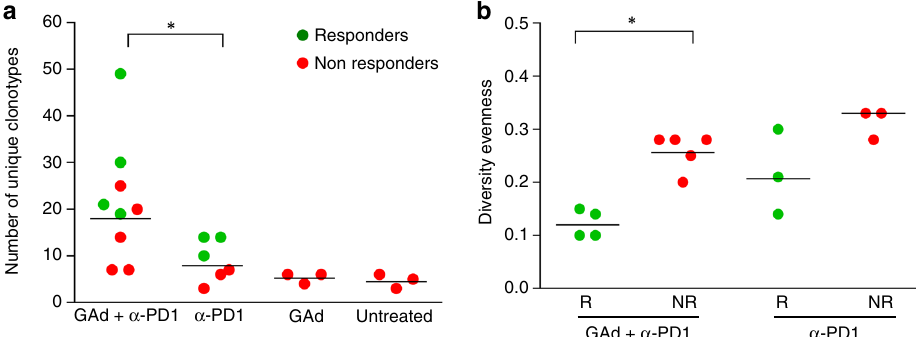
Fig. 5 Combined treatment of GAd and anti-PD1 induced enrichment and expansion of TCR- β clonotypes: a Number of clonotypes detected in tumors ( n = 3 – 5/group) for each group of treatment by analysis of TCR - β sequences (green circles are responder tumors, red circles non-responders). b Changes in Diversity evenness between responders (R) and non-responders (NR) to combo and anti-PD1 treatment. Diversity evenness was de fi ned as the minimum percentage of CDR3 sequences accounting for 50% of the reads mapped on TCR- β . * p < 0.05, two-tailed Mann – Whitney U test